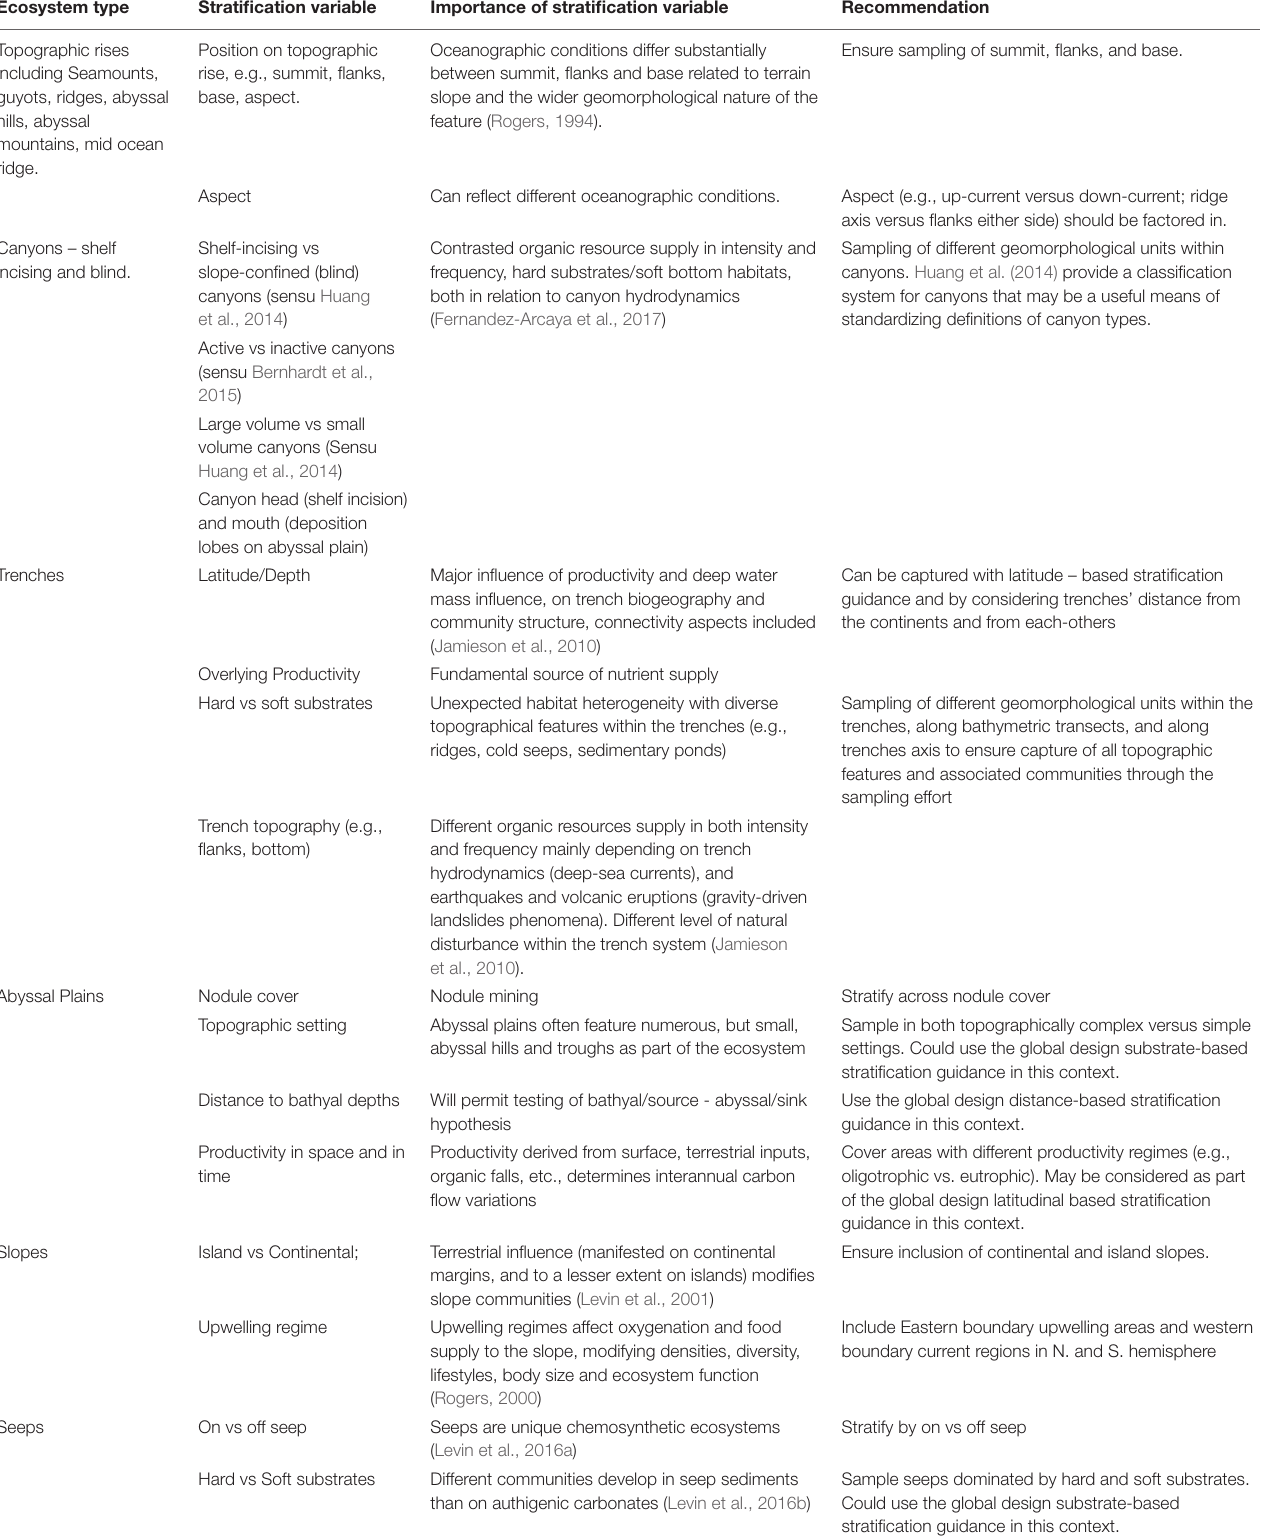
TABLE 1 | Ecosystem-specific considerations. Ecosystem type Stratification variable Importance of stratification variable Recommendation Topographic rises including Seamounts,